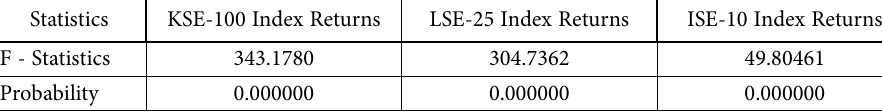
Table 3. ARCH effect in stock markets indices (source: authors’ estimation)